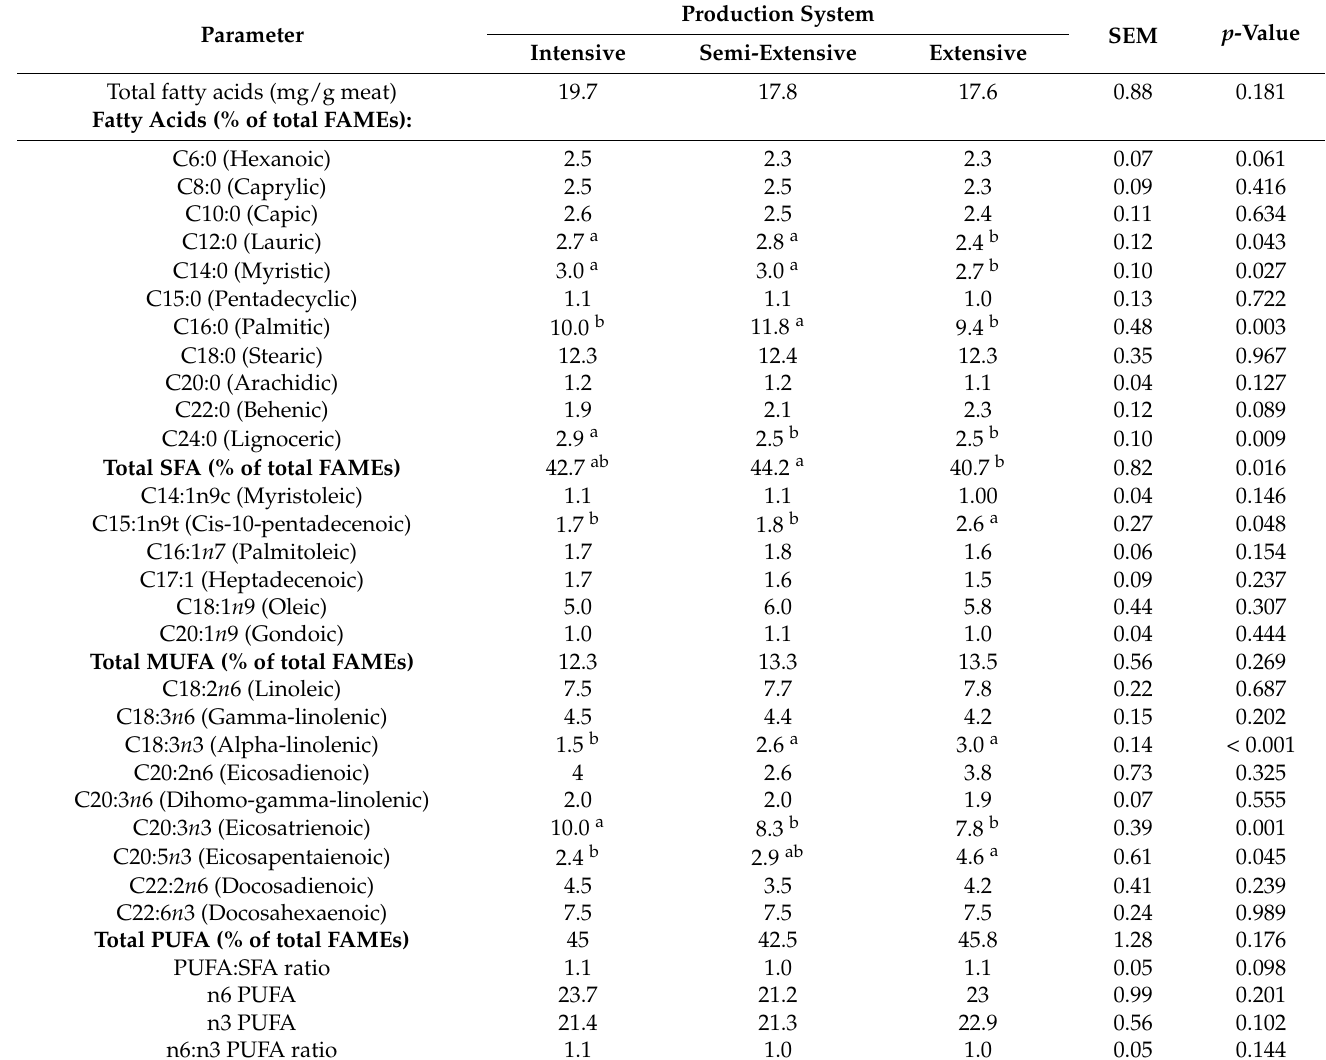
Table 5. LSMeans and the pooled standard error (SEM) of the fatty acid profiles of sub-adult male impala longissimus thoracis et lumborum meat as influenced by production system. A total mixed ration was fed in the intensive system ( n = 12), while supplementation (with the same ration) was provided on Savanna vegetation ( n = 12), and no supplementation was provided to the extensive system on Renosterveld vegetation ( n =